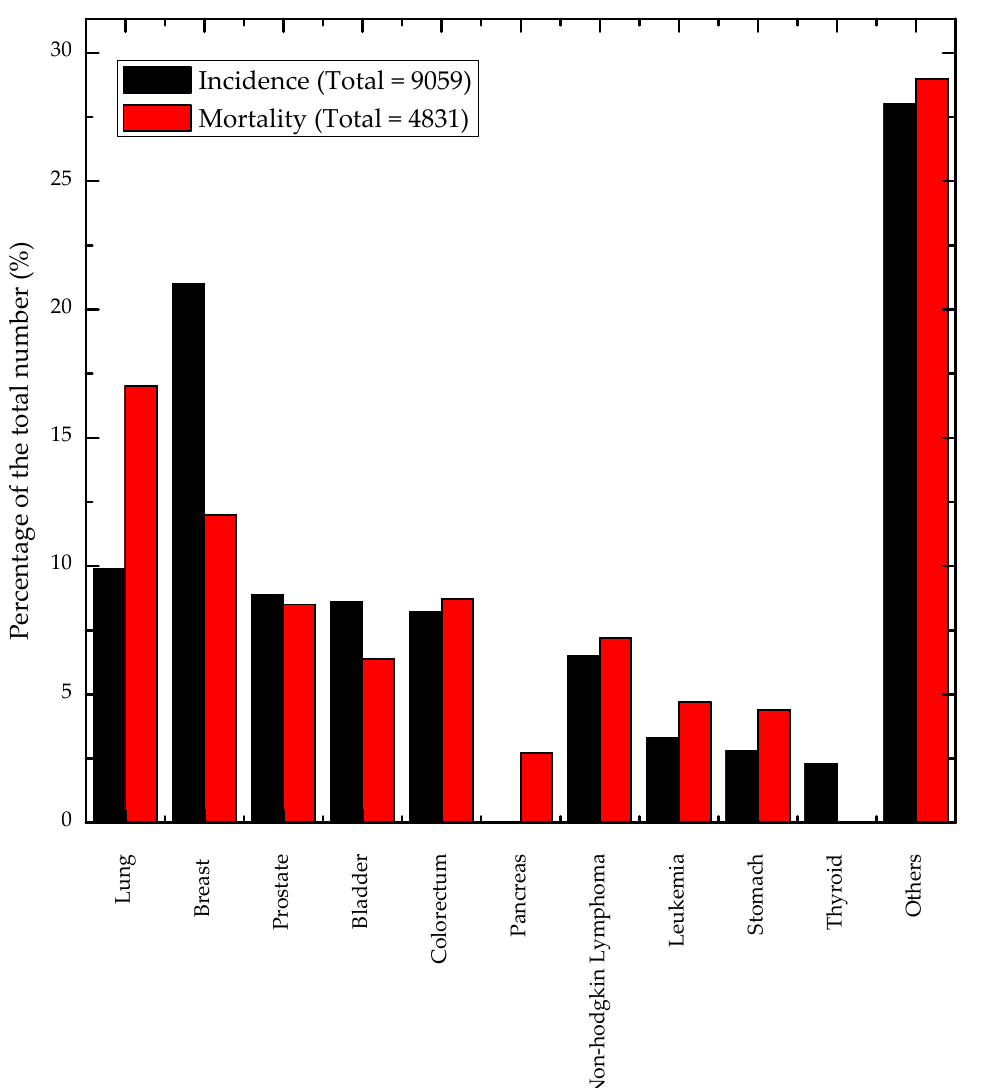
Figure 2. Rates and percentage of incidence and mortality of cancer in Lebanon.[15].